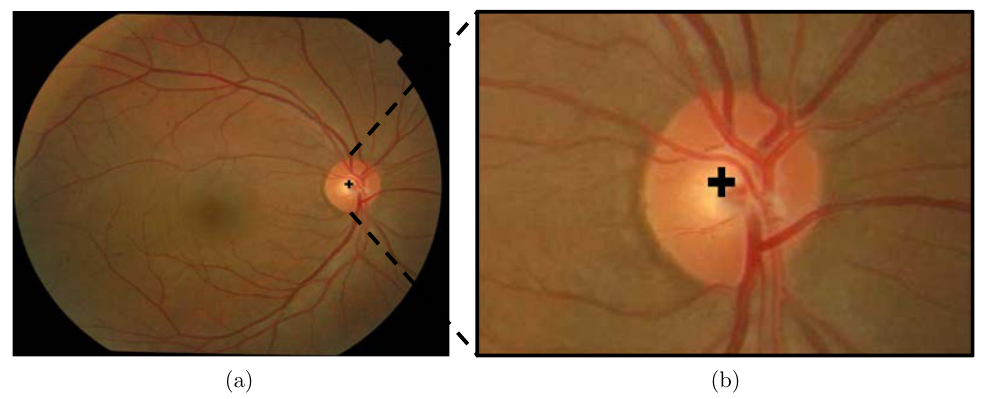
Fig. 6. OD Localization (a), Position of OD marked with its enlarged version in (b).